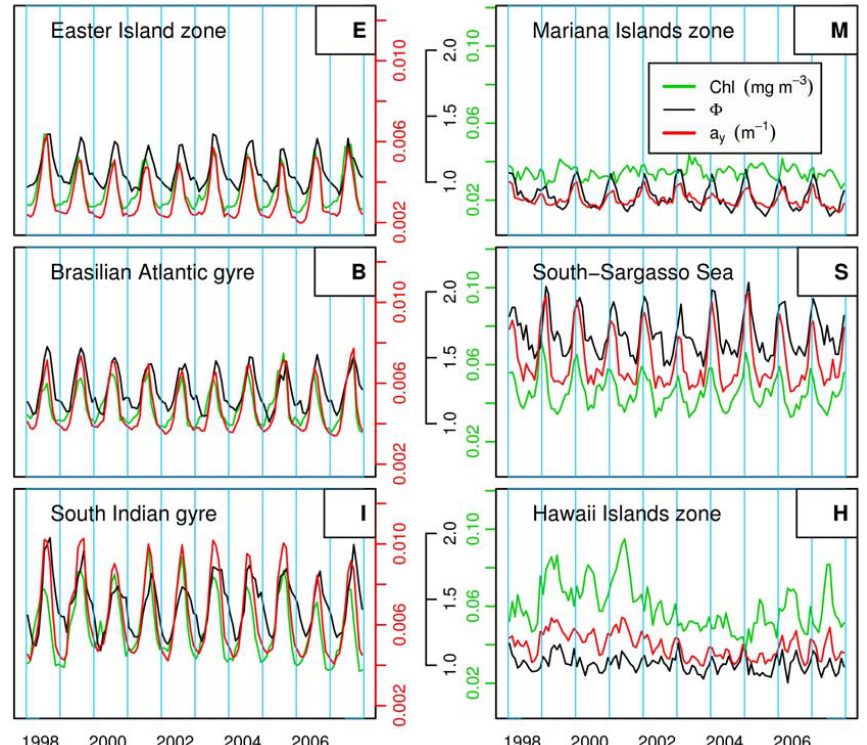
Fig. 2. Time series (1998–2007) of the three parameters, [Chl], a y (443), and 8 , as established from the monthly composites and by averaging the values of all pixels over each of the six selected zones (identifiers as in Table 1); to facilitate direct comparisons, the scales are identical for the six panels; green scale: [Chl] as mgm − 3 ; red scale a y (443) as m − 1 ; black scale, in the middle, 8 ,